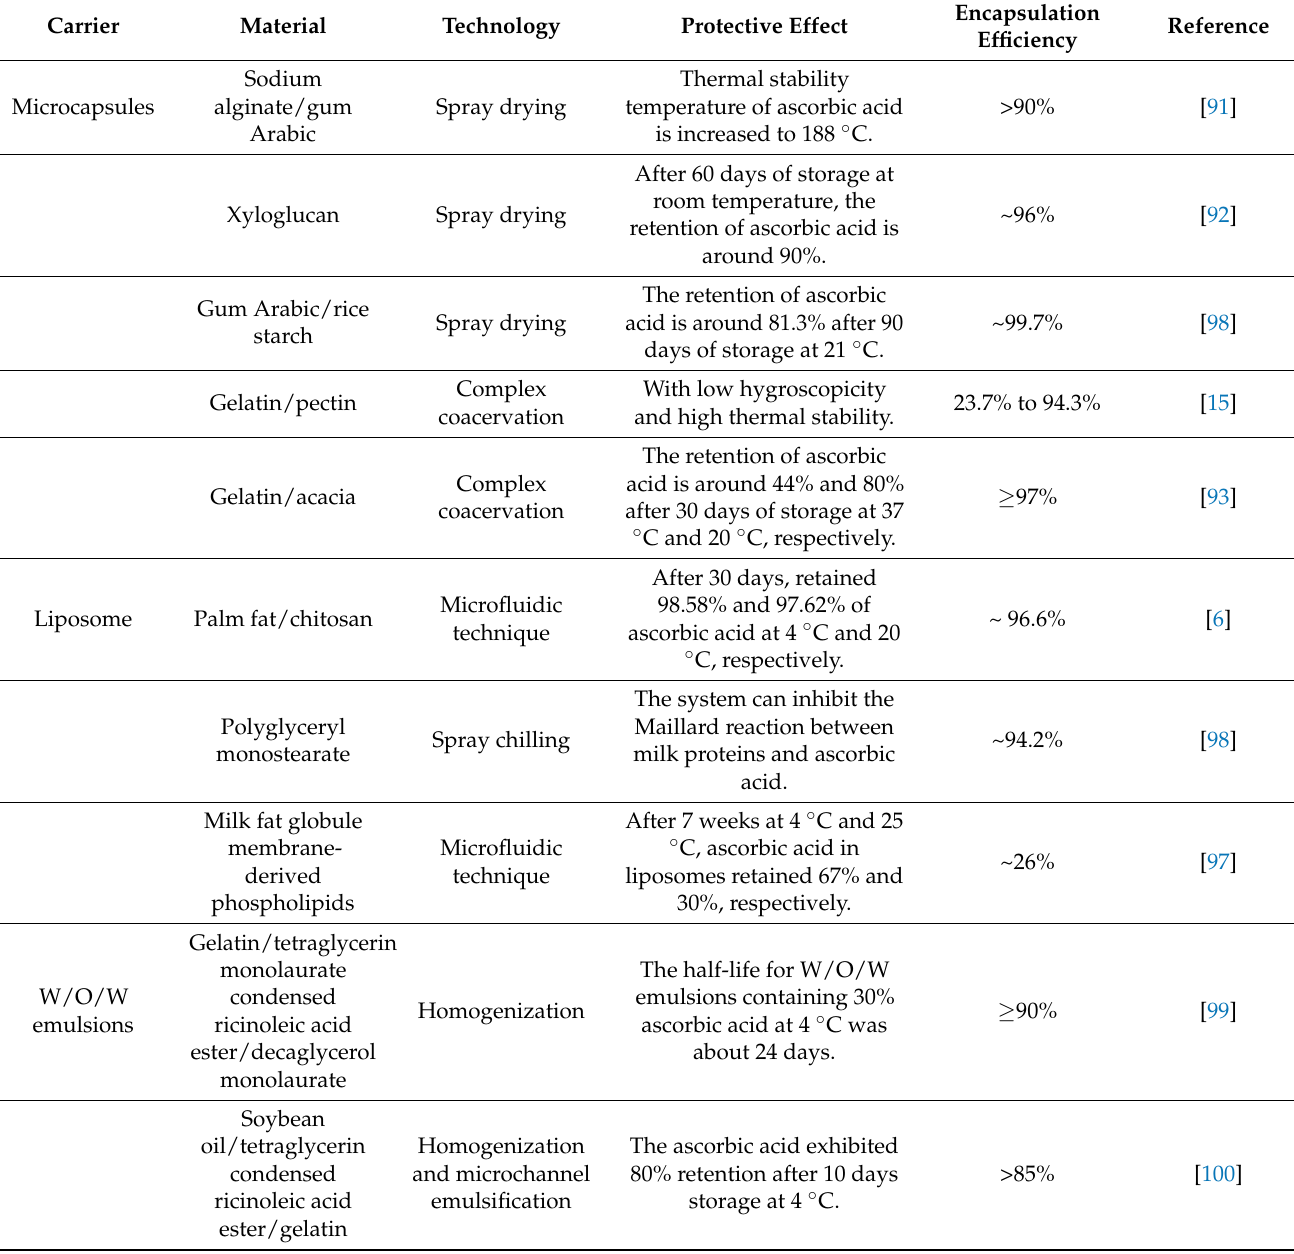
Table 1. Different types of bio-macromolecule delivery vehicles of ascorbic